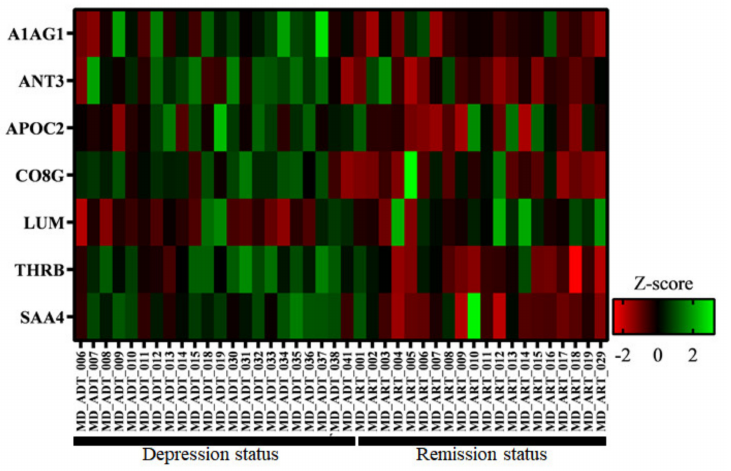
Figure 2. Differentially expressed proteins from patients with depression status compared to those with remission status. Proteins were significantly differentially expressed by more than 1.2-fold as shown using z-score. X -axis shows the samples used for analysis. ADT refers to depression group and ART refers to remission group. Y -axis shows the seven biomarker candidates from IDA-SWATH analysis. A1AG1: Alpha-1-acid glycoprotein 1, ANT3: Antithrombin-III, APOC2: ApolipoproteinC- II, CO8G: Complement component C8 gamma chain, LUM: Lumican, THRB: Prothrombin, SAA4: Serum amyloid A-4